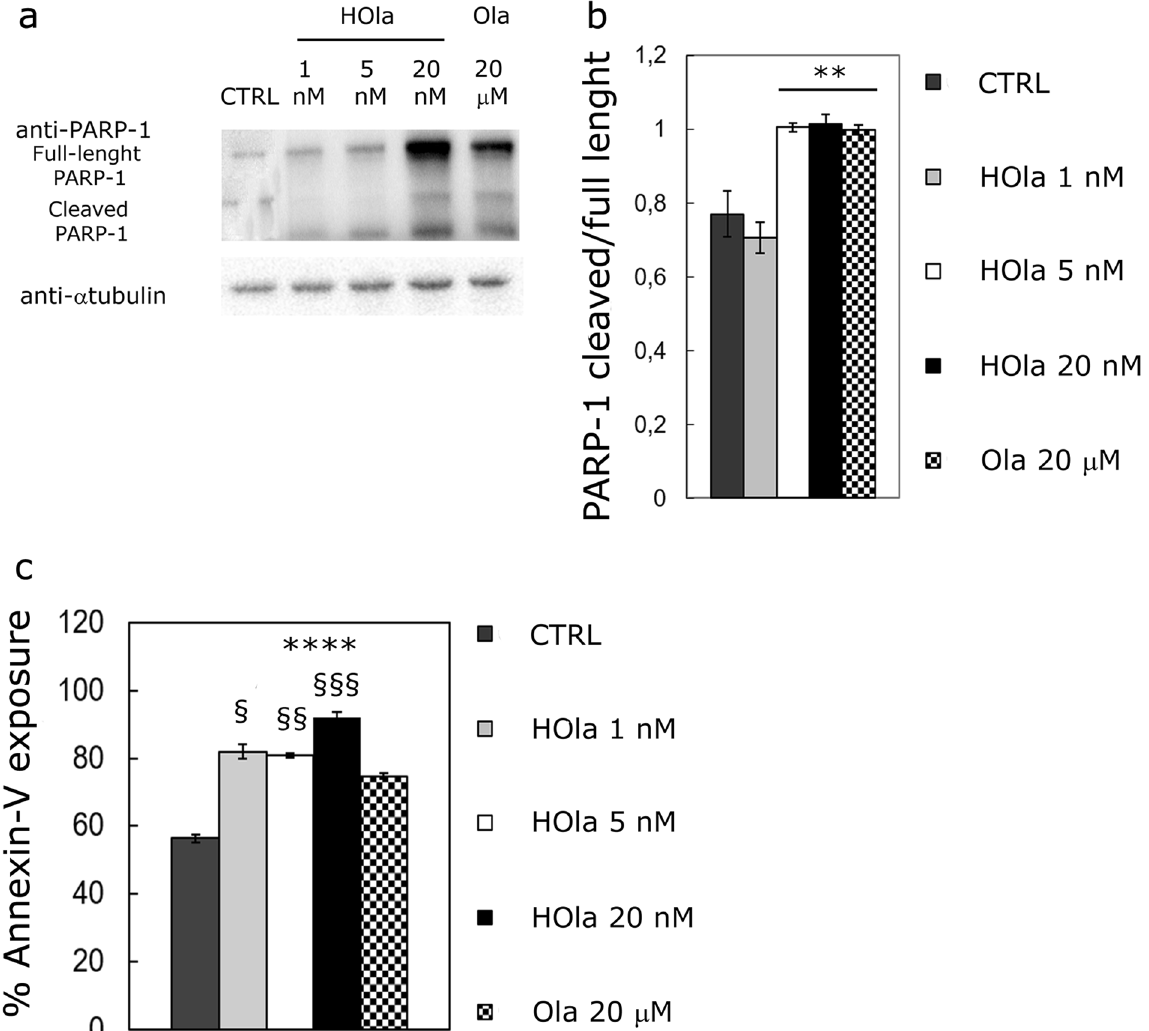
Figure 6. HOla is efficient in mediating PARP-1 cleavage due to Olaparib inhibition in TNBC cells. ( a ) HCC1937 were treated with increasing concentration of nanoformulated Ola (HOla; 1, 5 and 20 nM) in the presence of 5% FBS supplemented RPMI1640 medium for 72 h. As positive control, cells treated with 20 µ M Ola were used. At the end of incubation, cells were lysed and subjected to western blot analysis. ( b ) Relative amounts of cleaved PARP-1 were quantified by densitometry using ImageJ Software. Reported values are the mean of 6 samples ± s.e. Statistical significance vs . CTRL, ** P < 0.01 (Student’s t -test). ( c ) Cell death assay of HCC1937 cells treated with increasing concentration of nanoformulated Ola (HOla; 1, 5 and 20 nM) in the presence of 5% FBS supplemented RPMI1640 medium for 72 h. As positive control, cells treated with 20 µ M Ola were used, while untreated cells were used as negative control (untreated). Reported values represent the mean ± s. e. of three replicates. (Statistical significance vs . CTRL, *** P < 0.0005; vs . Ola § P < 0.05, §§ P < 0.005 and §§§ P <